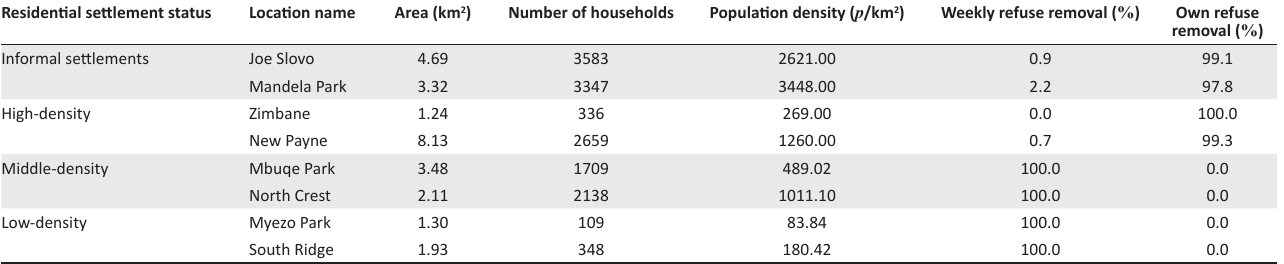
FIGURE 1: Map showing residential settlements and road network in TABLE 1: Description of waste management practices in the investigated communities. Residential settlement status